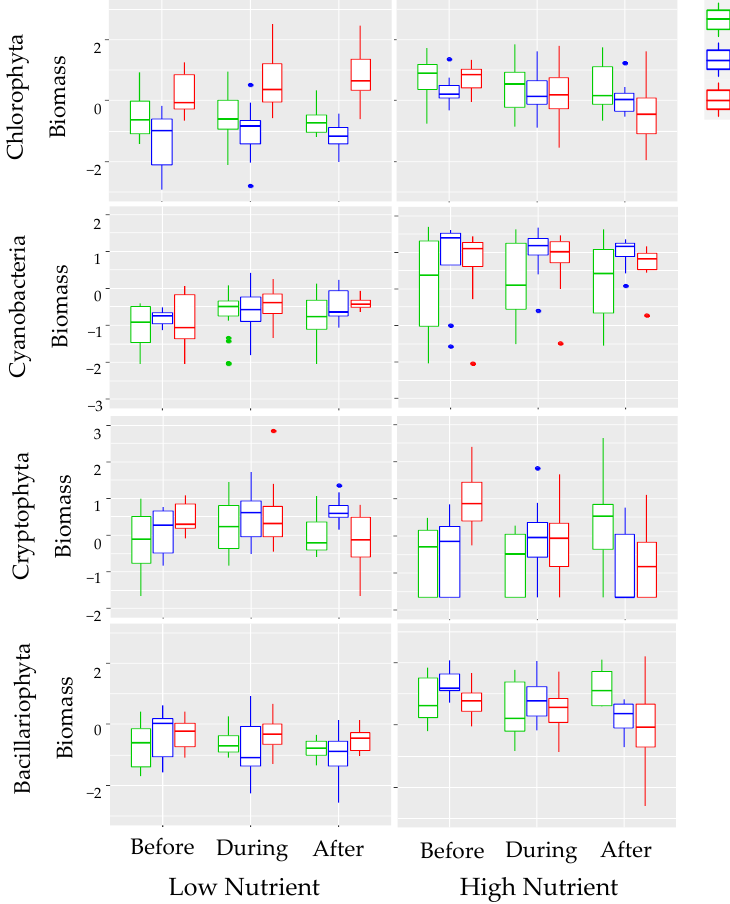
Figure 4. Bacillariophyta, Chlorophyta, Cyanobacteria, and Cryptophyta biomasses ( µ g / mL) boxplot graphs for all treatments in all periods. Box-Cox Power Transformation was applied to each dataset. Left panel is LN, right panel is HN (boxplots that are presented with medians and ‘hinges’ are versions of the first and third quartiles).